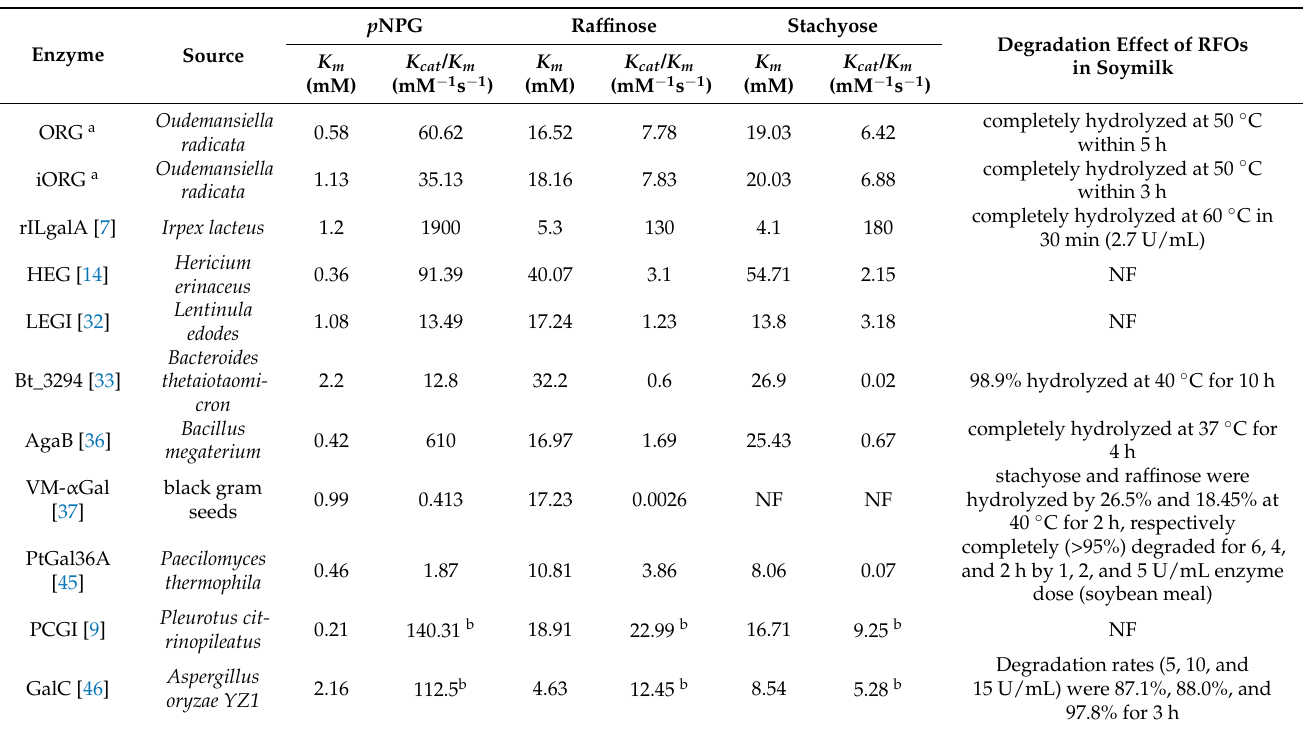
Table 6. Comparison of the kinetic constants, and soymilk RFOs degradation effect of different sources’ α -galactosidase.